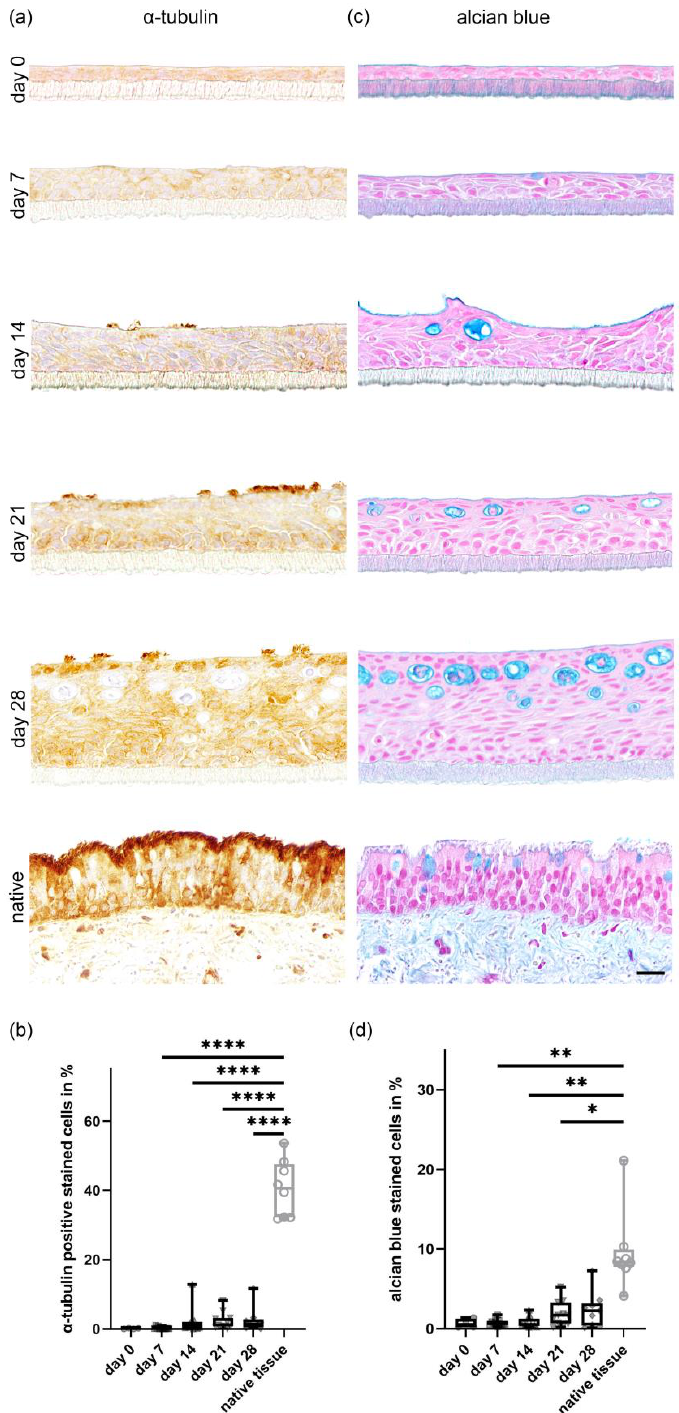
Figure 4. Characterization of mucociliary differentiation of respiratory epithelial cells cultured under air–liquid interface (ALI) conditions using histochemistry and immunohistochemistry. ( a ) Immunohistochemical staining for α -tubulin was performed in order to quantify the number of ciliated cells present in the cultures. Fully-formed cilia were present at day 14, with an increasing number during the following time points. The highest number of ciliated cells was seen in cultures at day 28 post-initiation of ALI conditions. ( b ) Ciliated cells were quantified by counting α -tubulin positive cells in five fields of view per section at 200 × magnification. ( c ) Alcian blue staining was applied